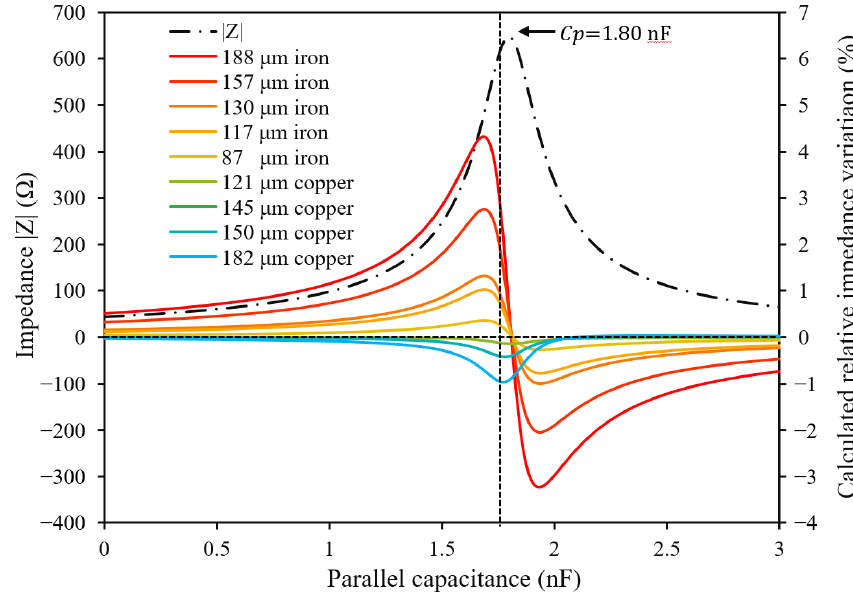
Figure 3. The parallel inductance – capacitance resonance circuit where, R Figure 3. The parallel inductance–capacitance resonance circuit where, R s = 3.015 Ω , L s = 3.507 µ H, and C p ranged from 0 nF to 3.0 nF. and C ranged from 0 nF to 3.0 nF. p